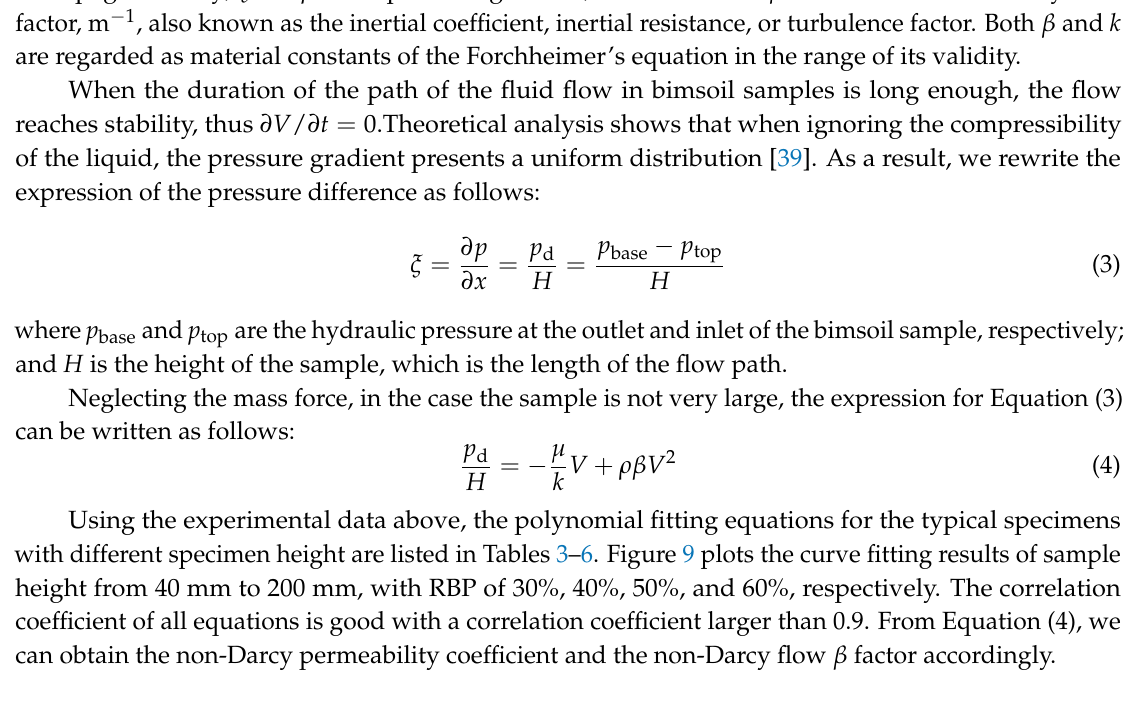
Table 3. The non-Darcy’s flow equations for typical specimens with rock block percentage of 30%, using Forchheimer equation.